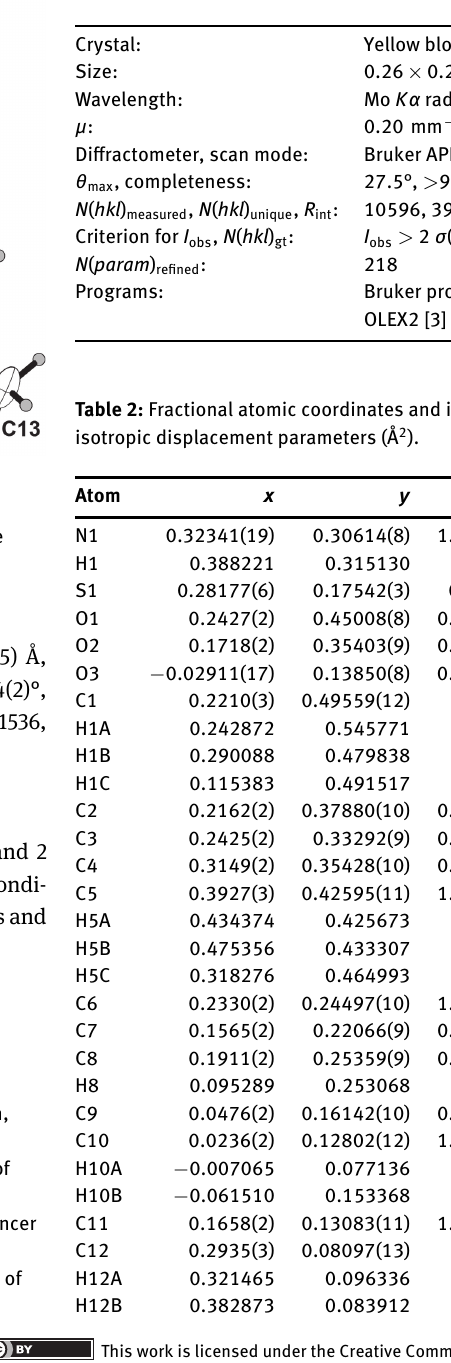
Table 1: Data collection and handling.